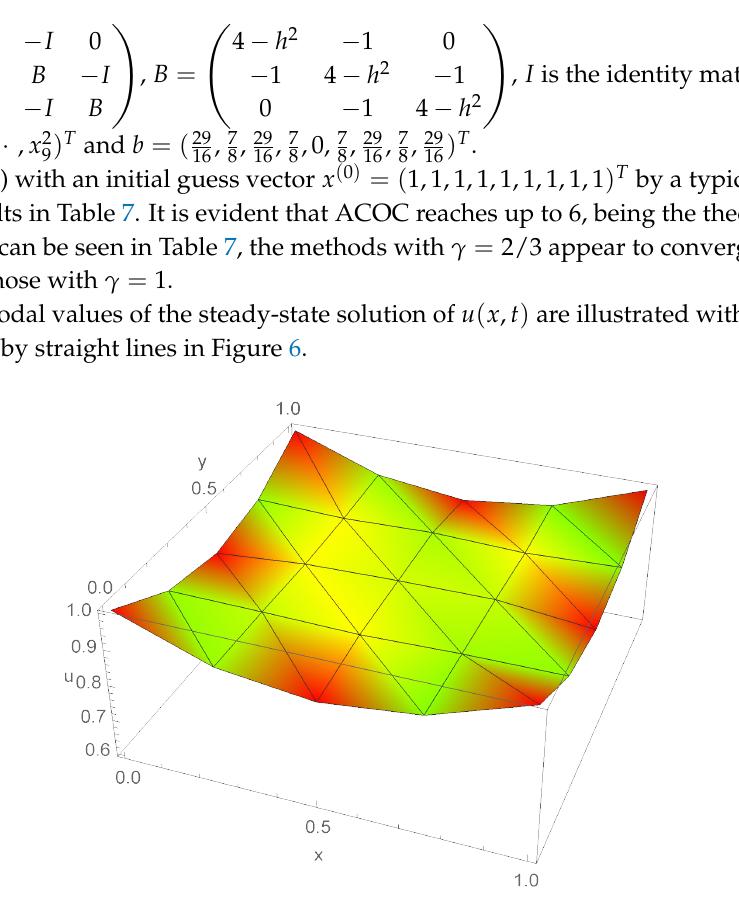
Figure 6. Steady state solution of the reaction-diffusion equation for Example